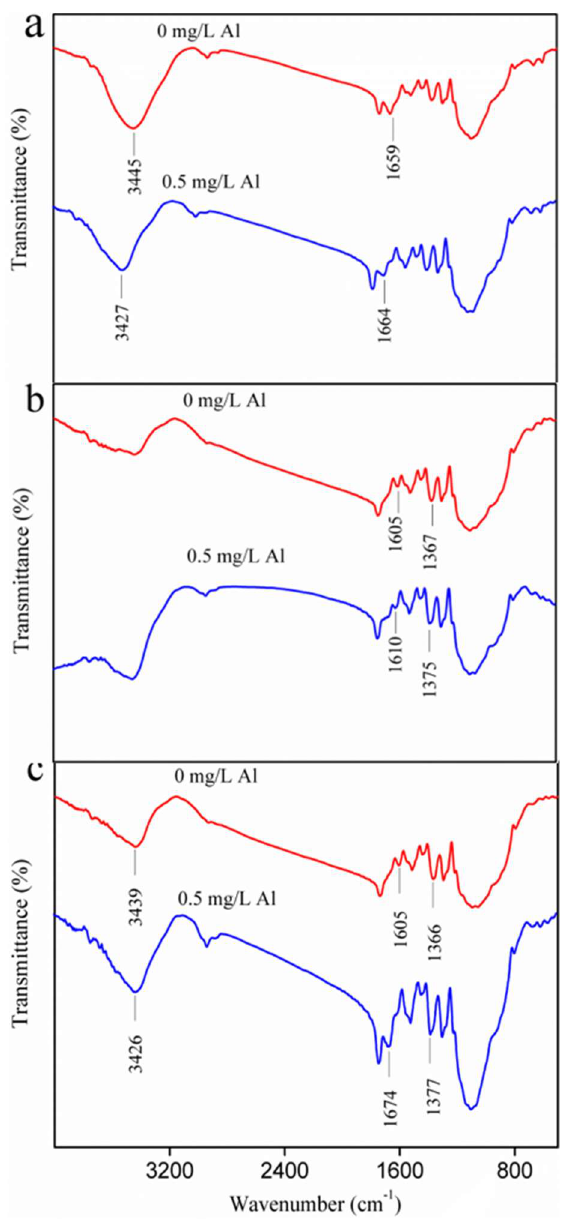
Figure 4. Fourier-transform infrared spectrophotometer (FTIR) spectra of the EPS fractions (( a ) S-EPS, ( b ) LB-EPS and ( c ) TB-EPS) extracted from biofilms cultivated with and without Al.